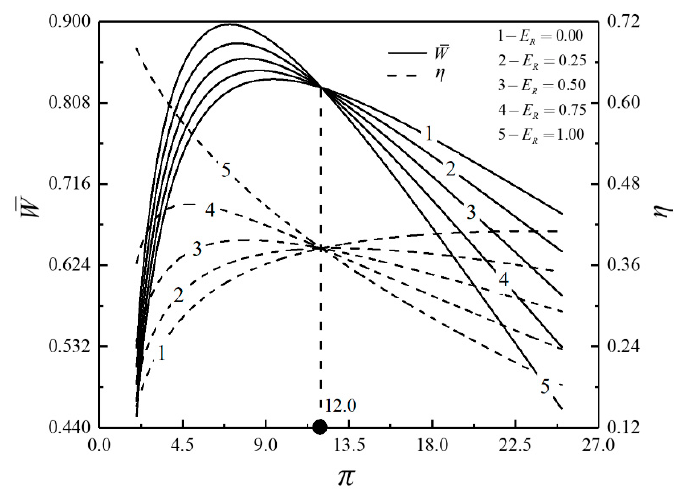
Figure 3. Relationships of W and η versus π with di ff erent E R